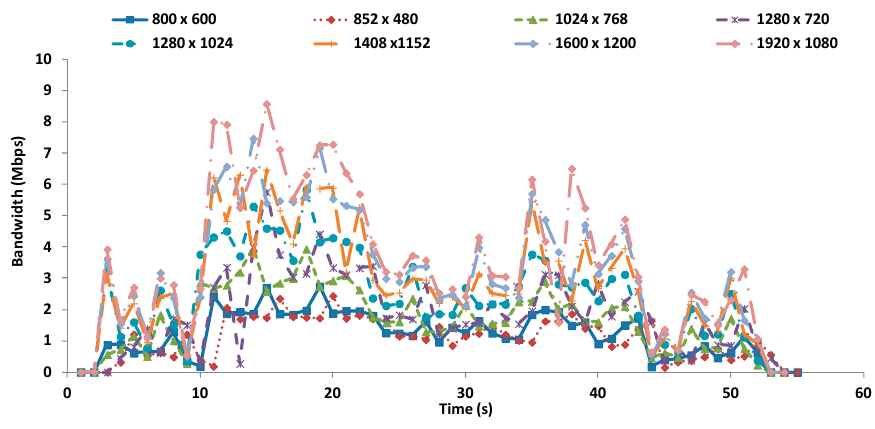
Figure 4. Bandwidth for videos at 60 fps.